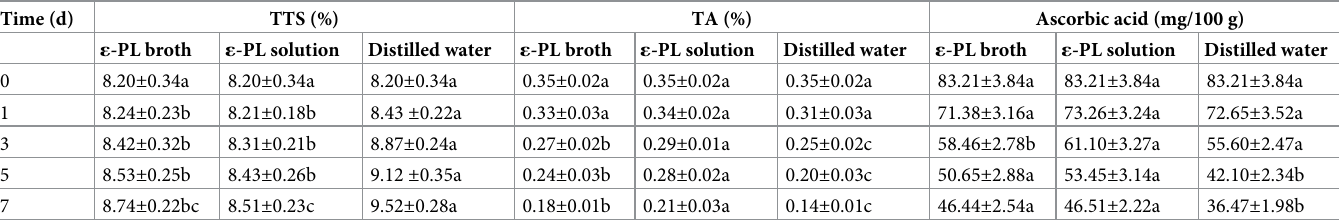
Table 4. TTS, TA, and ascorbic acid contents of guava at different storage time with different treatments. Time (d)